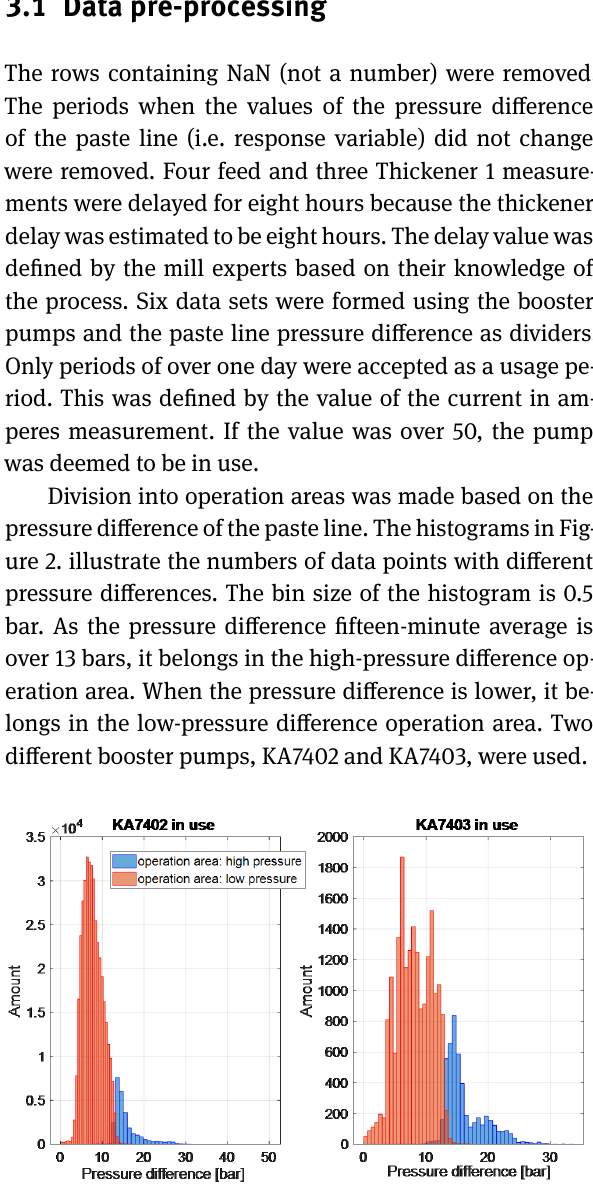
Figure 2: Dividing the data based on pressure difference (X-axis paste line pressure difference and Y-axis the number of values divided into different